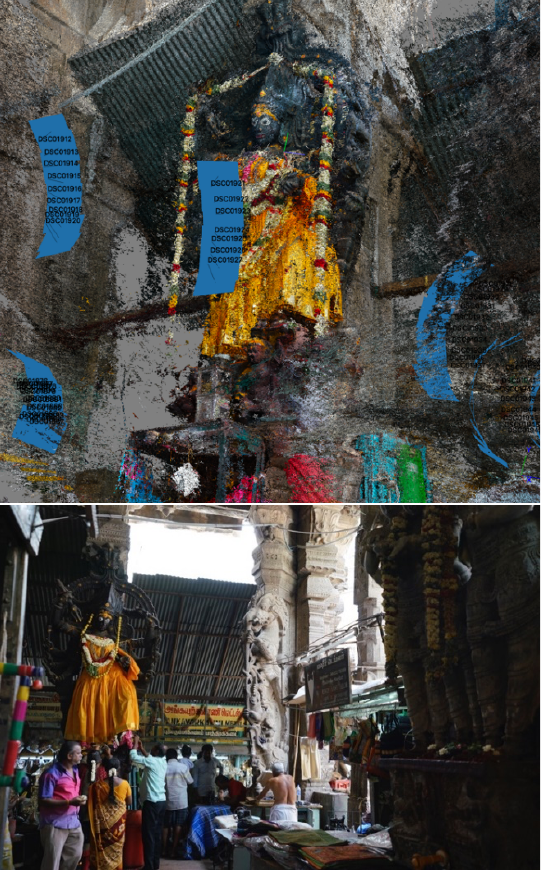
Figure 14. Pointcloud and photograph of the Kali statue at the West end using © Agisoft